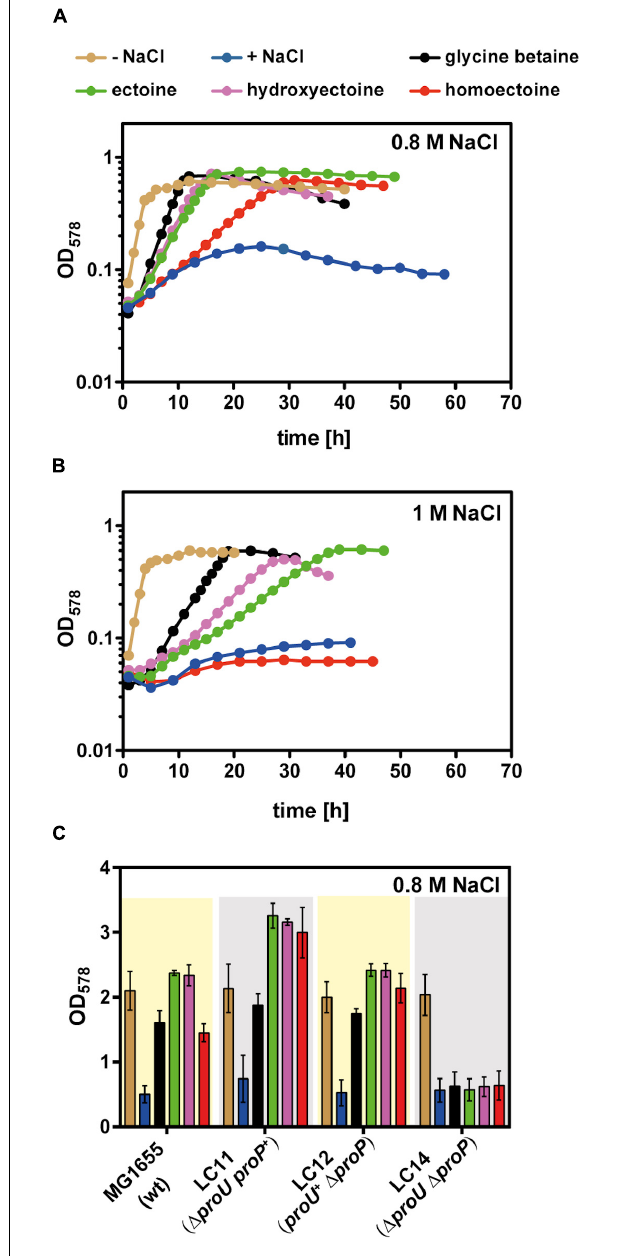
FIGURE 3 | Osmostress protection assay with glycine betaine, ectoine, 5-hydroxyectoine, and homoectoine. Growth of the E. coli strain MG1655 ( proU + proP + ) in MMA without NaCl and in MMA containing (A) 0.8 M NaCl or (B) 1 M NaCl and 1 mM of the indicated osmostress protectants; growth of the cultures was monitored for 60 h. The OD 578 of the cultures was measured hourly in a plate reader (Epoch2, BioTek). Each osmoprotection assay was conducted with two independently grown cultures. A representative set of growth curves is shown. (C) The E. coli strains MG1655 ( proU + proP + ), LC11 ( proU − proP + ), LC12 ( proU + proP − ), and LC14 ( proU − proP − ) were grown either in MMA or MMA containing 0.8 M NaCl in the absence or presence of the osmostress protectants (1 mM) in shake flasks. The final growth yield was determined by measuring the OD 578 of the cultures after 30 h. The bars shown are the means and standard deviations of three independently grown